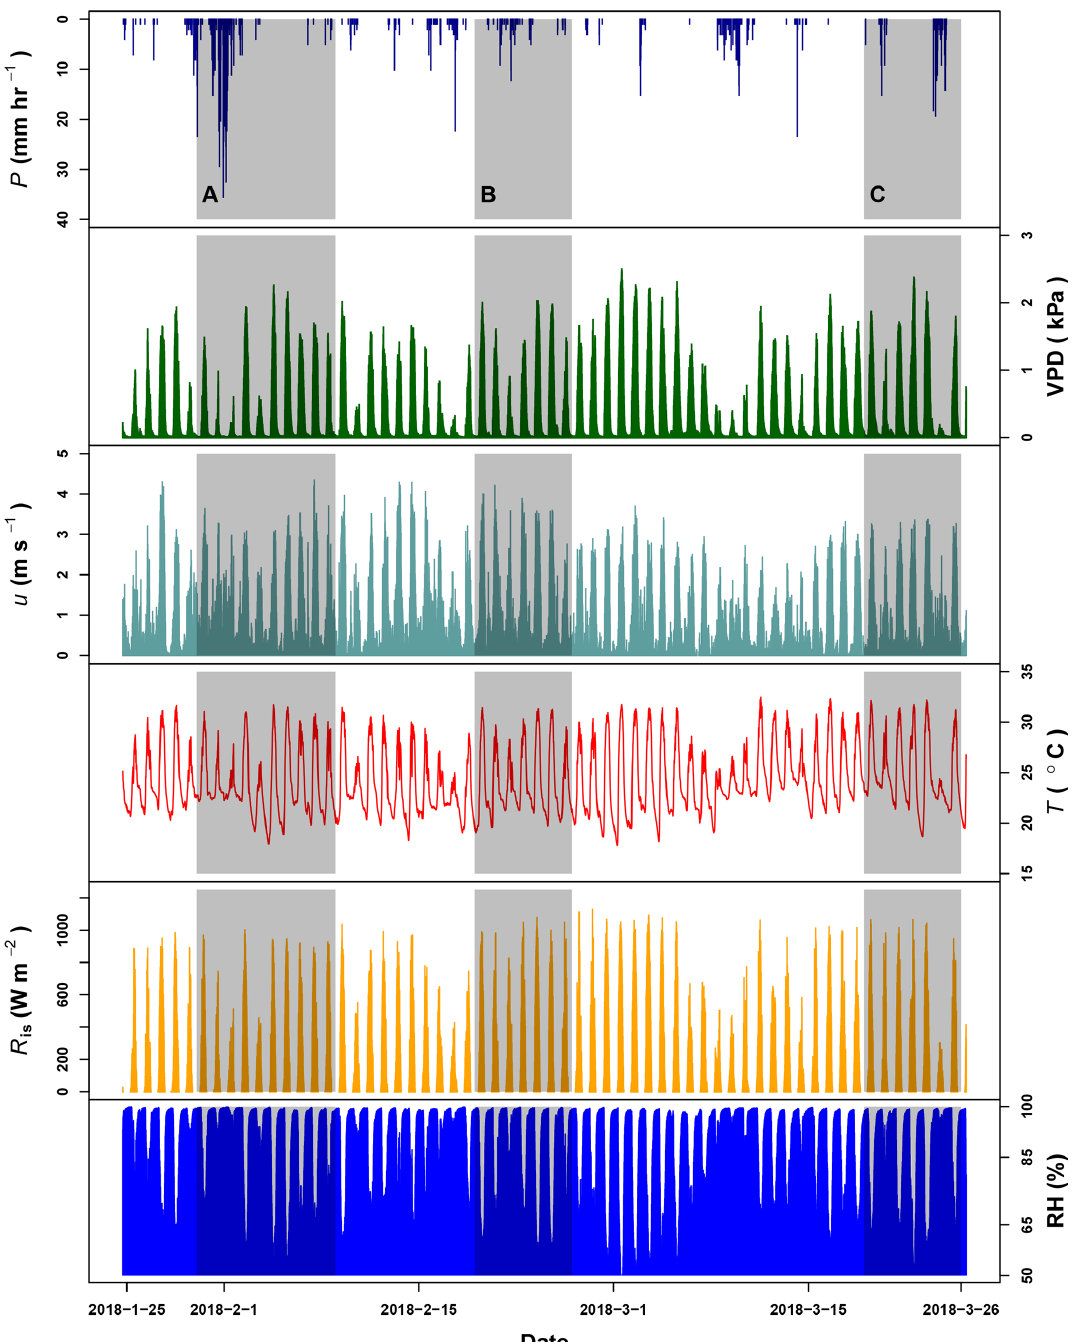
Figure G1. Precipitation ( P ), vapor pressure deficit (VPD), wind speed ( u ) and temperature ( T ) registered by the meteorological station at La Selva Biological Station (LSBS). The monitoring period covered from 20 January to 25 March 2018. Shadowed areas represent the three periods when water samples were collected at the MRI